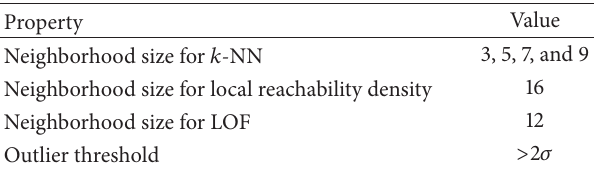
Table 3: Values of various parameters for the enhanced 𝑘 -NN